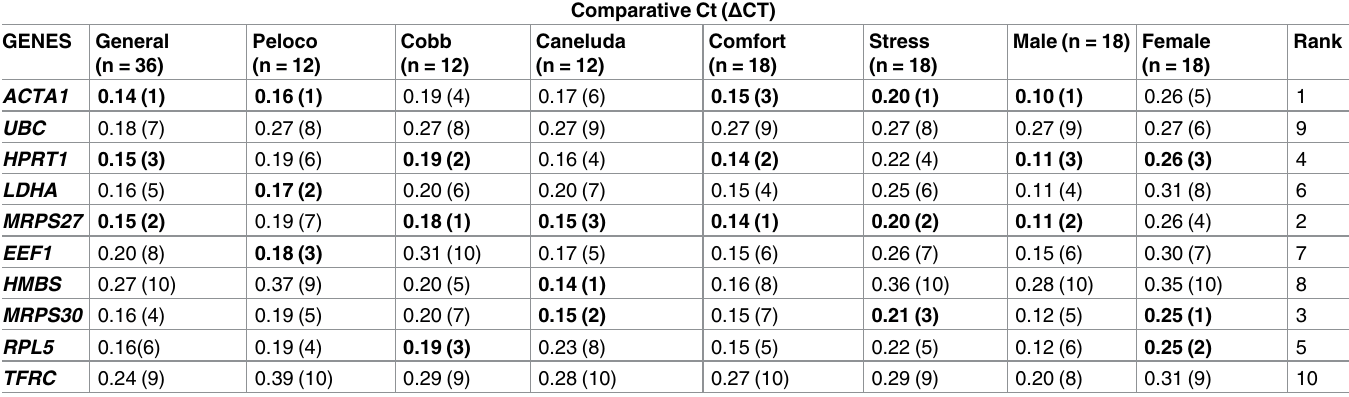
Table 8. Ranking with stability values for each treatment (genetic group, sex, and environment) in chicken obtained from Comparative Ct ( Δ Ct) analysis. Values into the parenthesis refer to rankingby ComparativeCt ( Δ Ct) to each treatment. Values on the last column refer to the ranking positionby RankAggreg packageamong all the treatments.